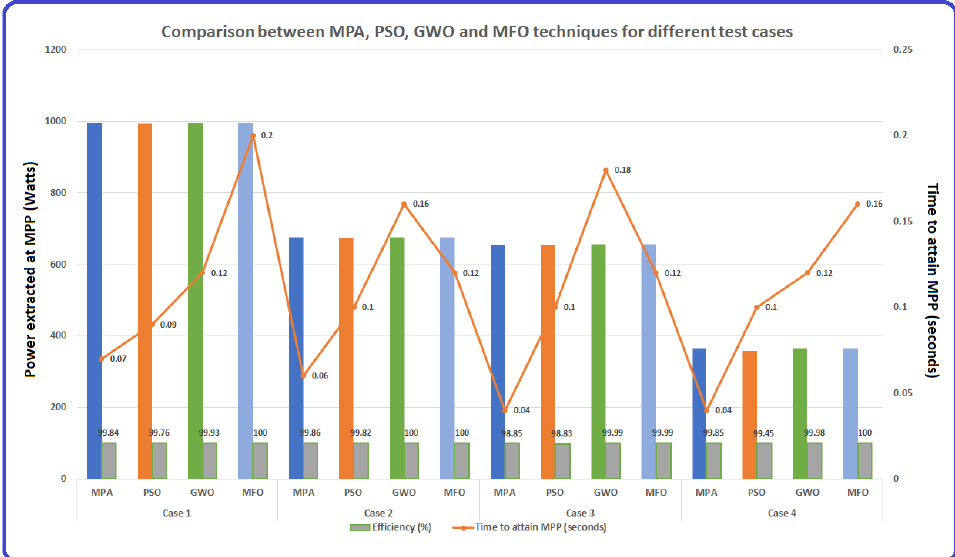
Figure 12. Comparison of MPA, PSO, GWO, and MFO techniques for four different test cases.